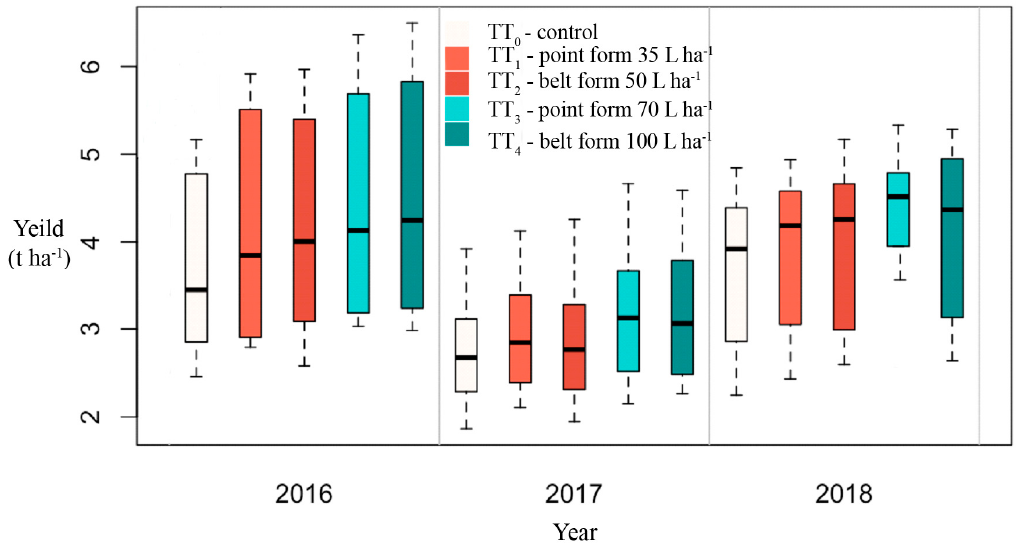
Figure 7. Yield values depending on the liquid starter fertilizer treatment.